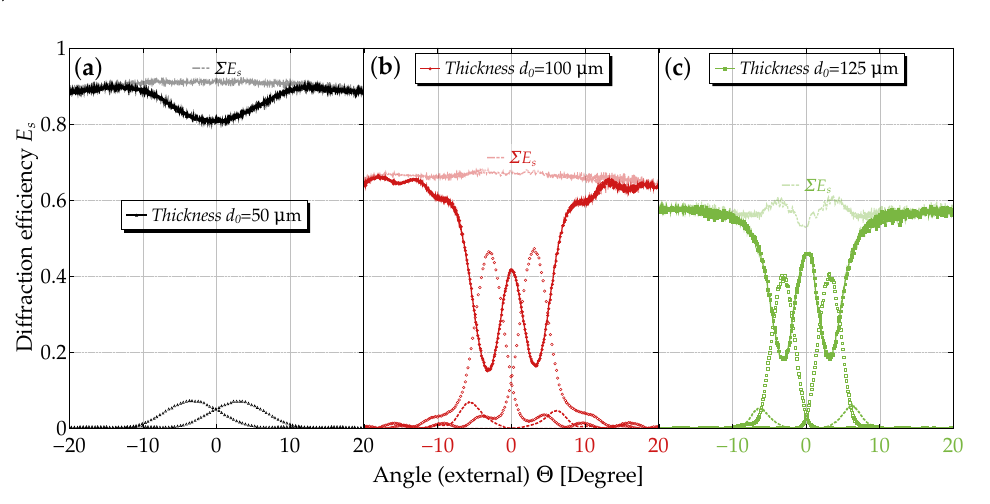
Figure 6. Diffraction efficiency after saturation for a recording time of t p = 12. E 0, ± 1, ± 2 as a function of the angle of incidence for: ( a ) d 0 = 50 µ m; ( b ) d 0 = 100 µ m; and ( c ) d 0 = 125 µ m. Zero diffraction orders are indicated by filled symbols, first diffraction orders by open symbols and second orders by dotted lines. The latter are invisible for d 0 = 50 µ m because of their low values. In addition, for each thickness value, the sum of all diffraction orders ∑ s = − 2, − 1... + 2 E s is shown as a faint line. The rapid oscillations are interference fringes due to the plane-parallel glass